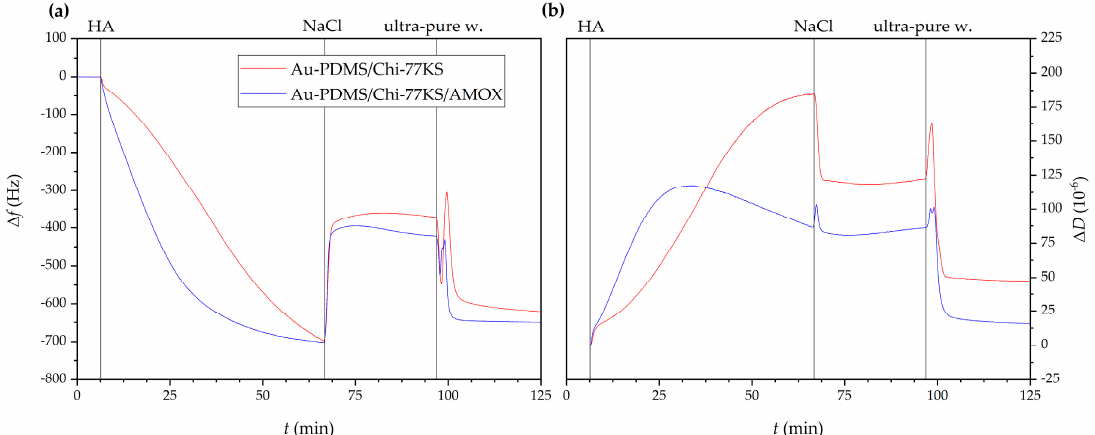
Figure 2. Changes in QCM-D frequency ( a ) and dissipation shift ( b ) as a function of time for the adsorption of HA onto Au-PDMS/Chi-77KS and Au-PDMS/Chi-77KS/AMOX surfaces.